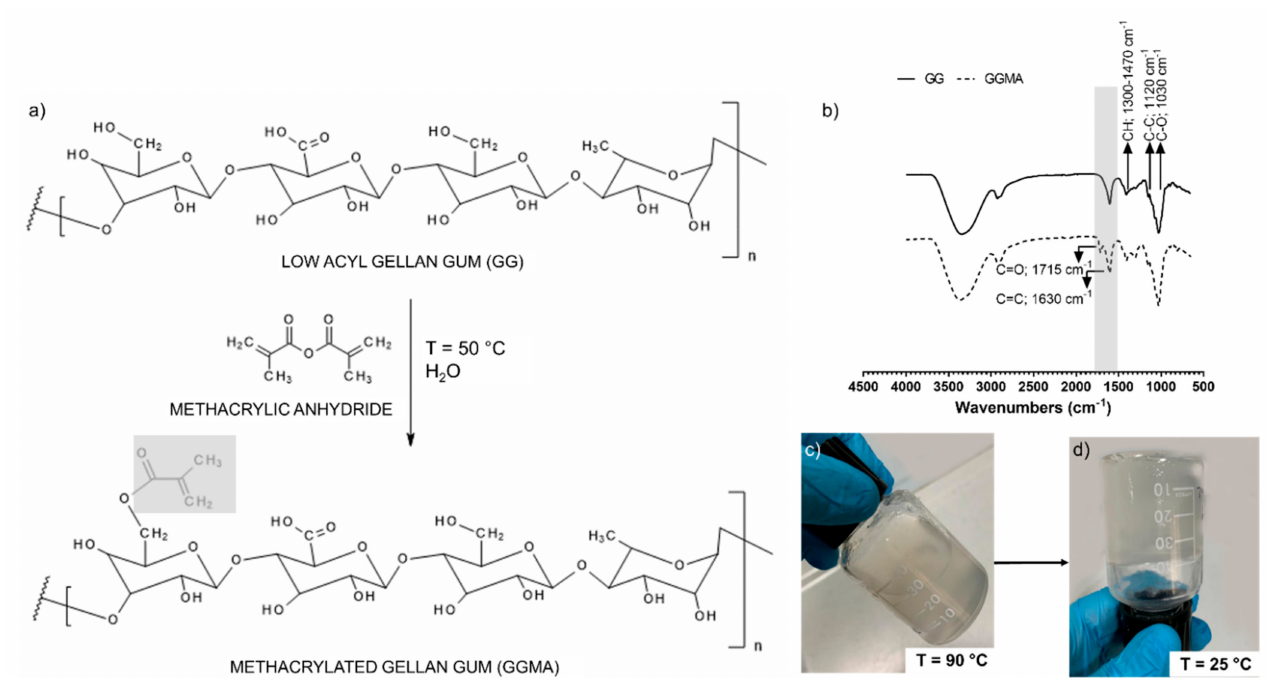
Figure 2. ( a ) Schematic illustration of the methacrylation reaction between low acyl gellan gum (GG) and methacrylic anhydride (MA) to synthesize methacrylated gellan gum (GGMA). ( b ) ATR-FTIR spectra of GG (top) and GGMA (bottom). ( c ) Representative photograph of GGMA solution at 90 ◦ C and ( d ) at 25 ◦ C, showing the system’s turbidity and the transition phase from liquid to gel